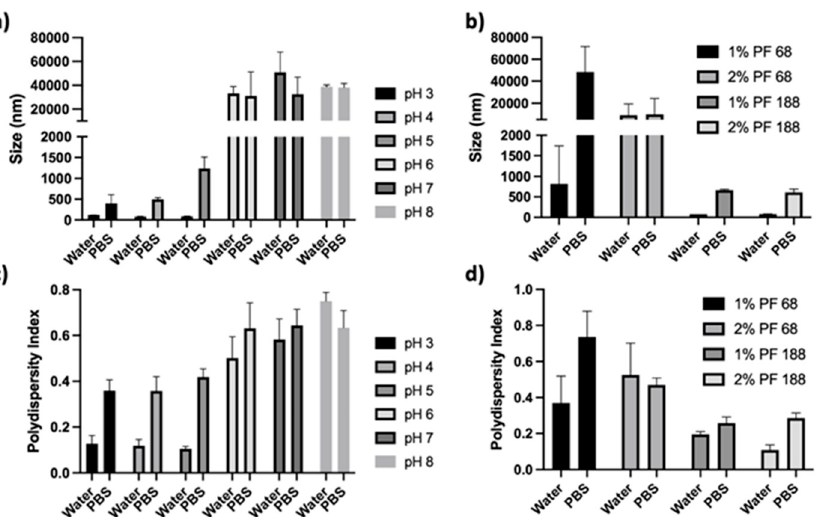
Figure 5. Post-functionalization of Zein nanoparticles (NPs) in varying experimental conditions: ( a ) size of Zein NPs post-functionalized with 3.0 mg/mL polyethylene glycol (PEG)-N-hydroxysuccinimide (NHS) in an unbuffered system adjusted directly with acetic acid; ( b ) size of Zein NPs post-functionalized with 3.0 mg/mL PEG-NHS in an unbuffered system containing 0.5% Tween 80 and varying levels of Pluronic (PF) 68 or 188; ( c ) polydispersity of Zein NPs post-functionalized with 3.0 mg/mL PEG-NHS in an unbuffered system adjusted directly with acetic acid; and ( d ) polydispersity of Zein NPs post-functionalized with 3.0 mg/mL PEG-NHS in an unbuffered system containing 0.5% Tween 80 and varying levels of PF 68 or 188.